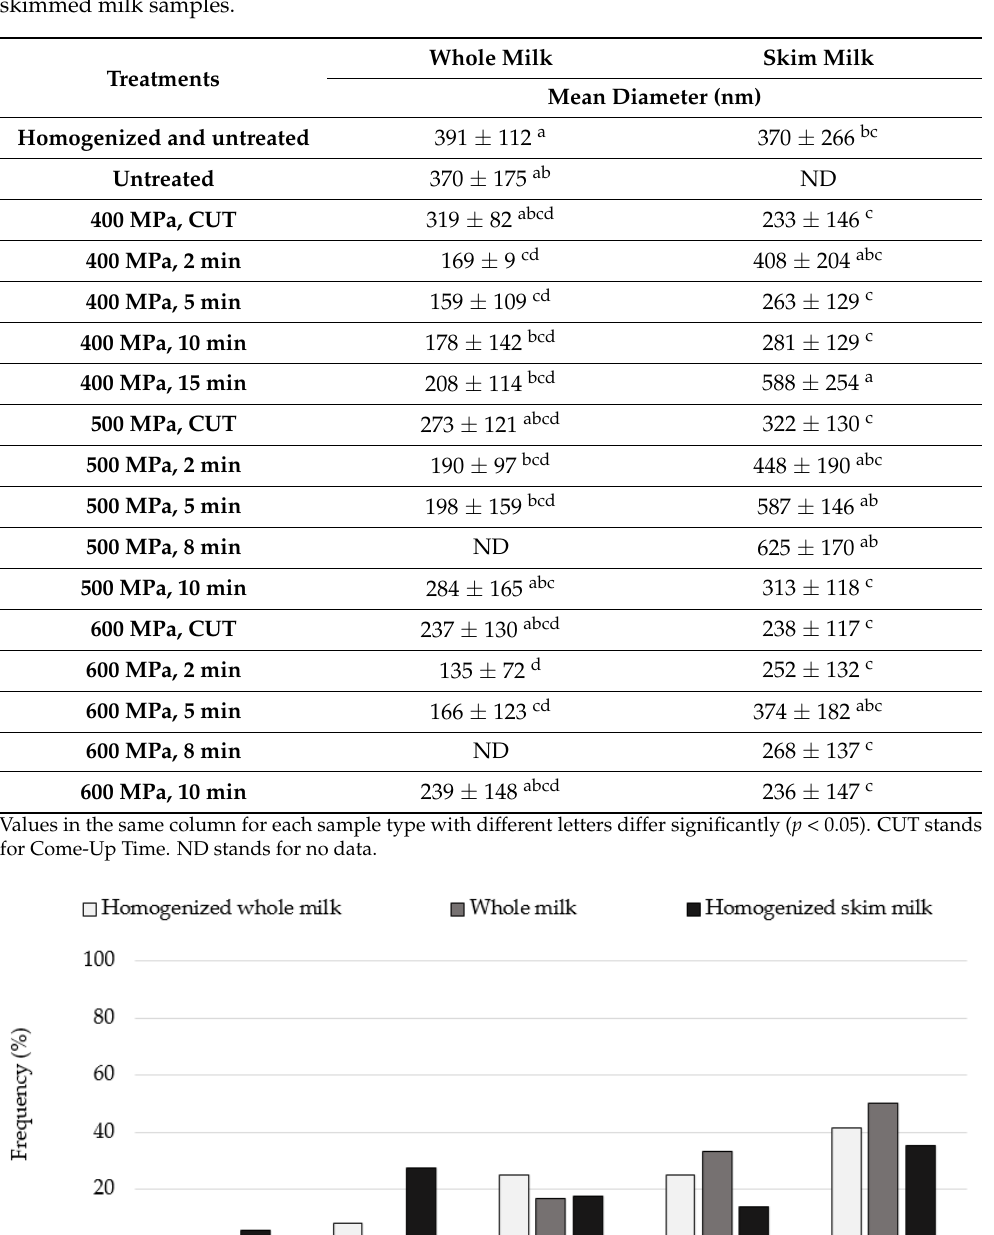
Table 2. Diameter (nm) of the casein micelles obtained from the SEM micrographs of the whole and skimmed milk samples.